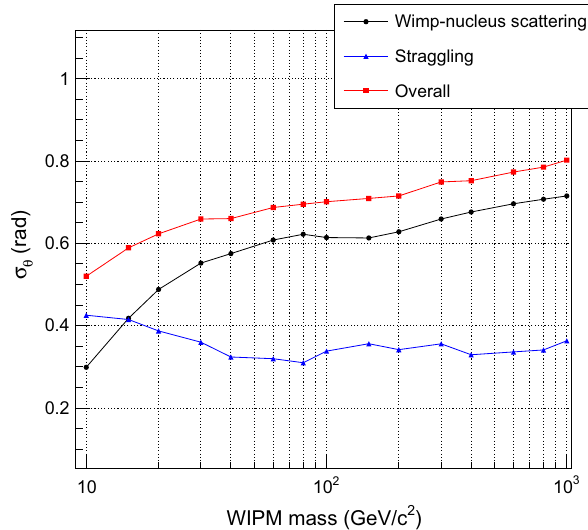
Fig. 3 Overall angular deviation of nuclear recoils in an emulsion tar- get as a function of the WIMP mass (red boxes). The two components due to the WIM-nucleus scattering (black dots) and the straggling (blue triangles) are also shown